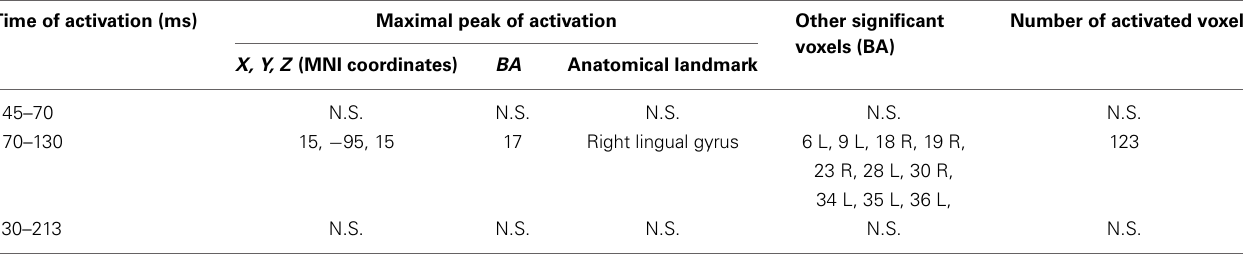
Table 3 | Results from discrete time windows sLORETA analysis (mean neural activity, t- statistic).